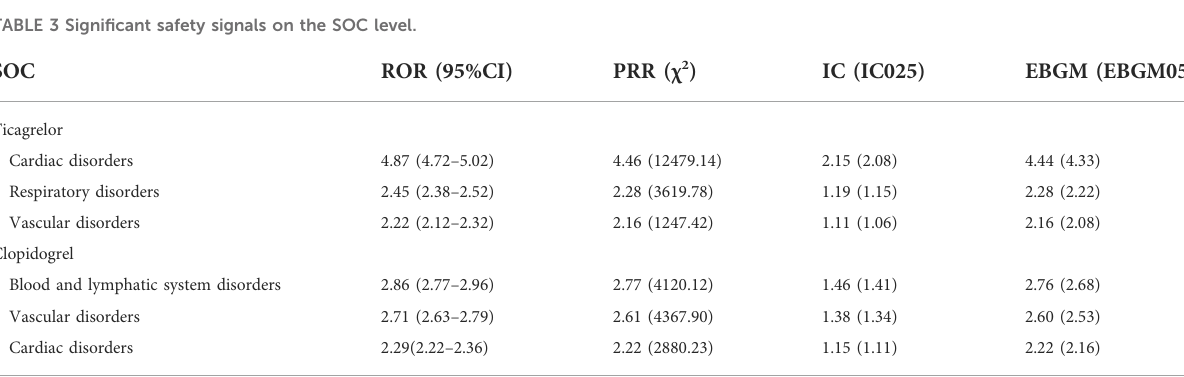
TABLE 3 Signi fi cant safety signals on the SOC